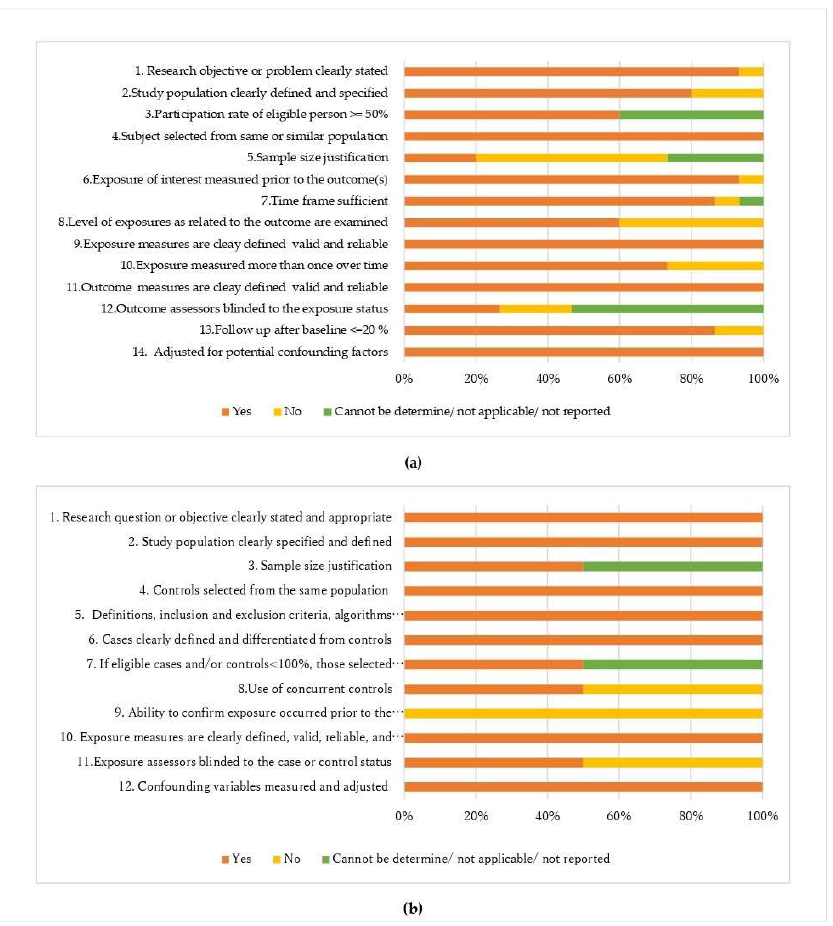
Figure 2. Quality assessment of included ( a ) cohort and cross-sectional studies ( n = 15 studies), and ( b ) case–control studies ( n = 2 studies) using the National Institute of Health (NIH) study quality assessment tools [16].